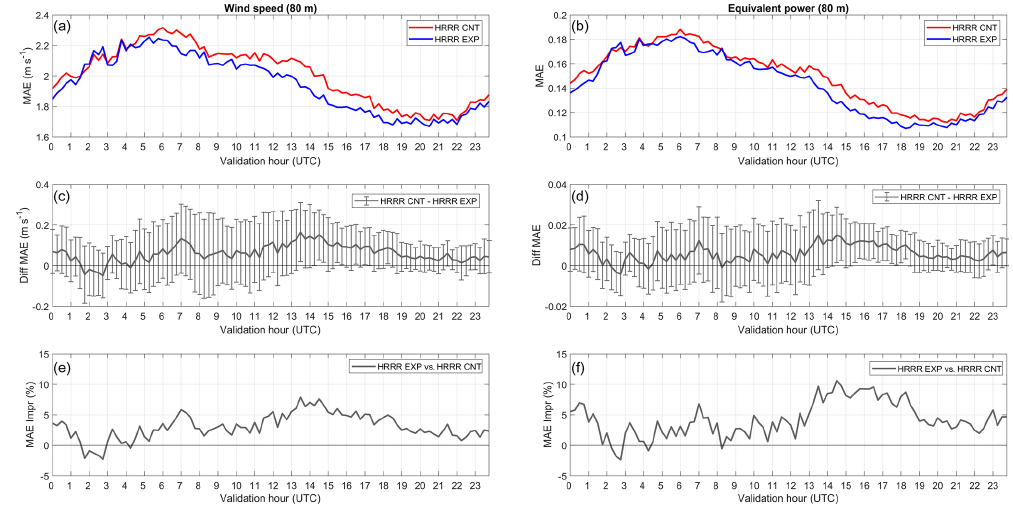
Figure 5. Panels (a, c, e) : HRRR EXP vs. HRRR CNT MAE for 80m wind speed. Panels (b, d, f) : as for (a, c, e) , but for 80m wind power, showing the impact of the experimental physics. Panels (a) and (b) are MAEs, (c) and (d) are differences between MAEs of the HRRR CNT √ n interval of the 95% confidence level), and (e) and (f) are the percentage MAE run and HRRR EXP run (error bars represent the ± 1 . 96 σ/ relative improvement of the HRRR EXP model over the HRRR CNT model.